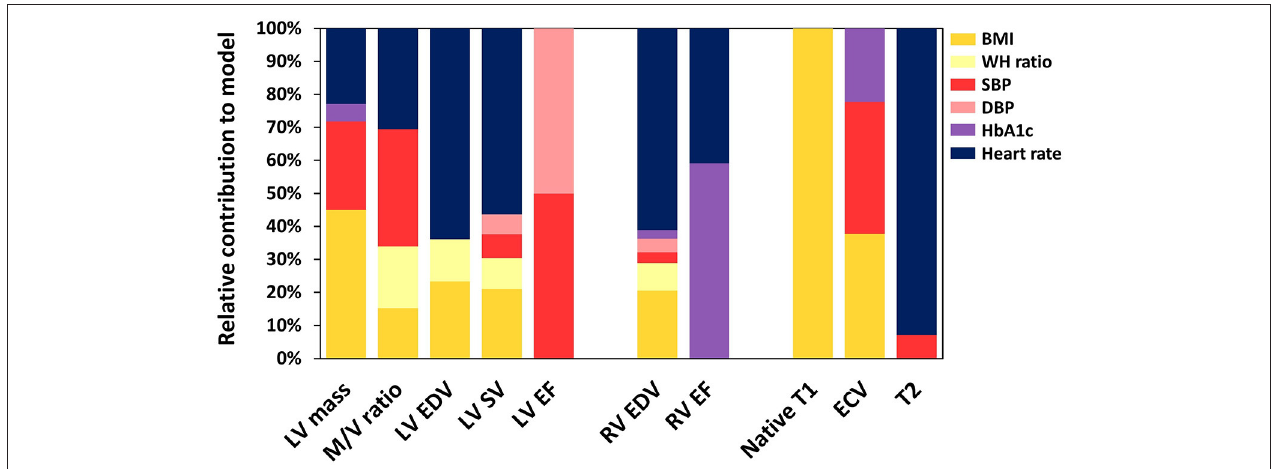
FIGURE 2 | The relative contribution of risk factors to the explanation of variation in cardiac MRI results. LV, left ventricle; M/V, mass/volume; EDV, end-diastolic volume; SV, stroke volume; EF, ejection fraction; RV, right ventricle; ECV, extracellular volume; BMI, body mass index; WH, waist96hip; SBP, systolic blood pressure; DBP, diastolic blood